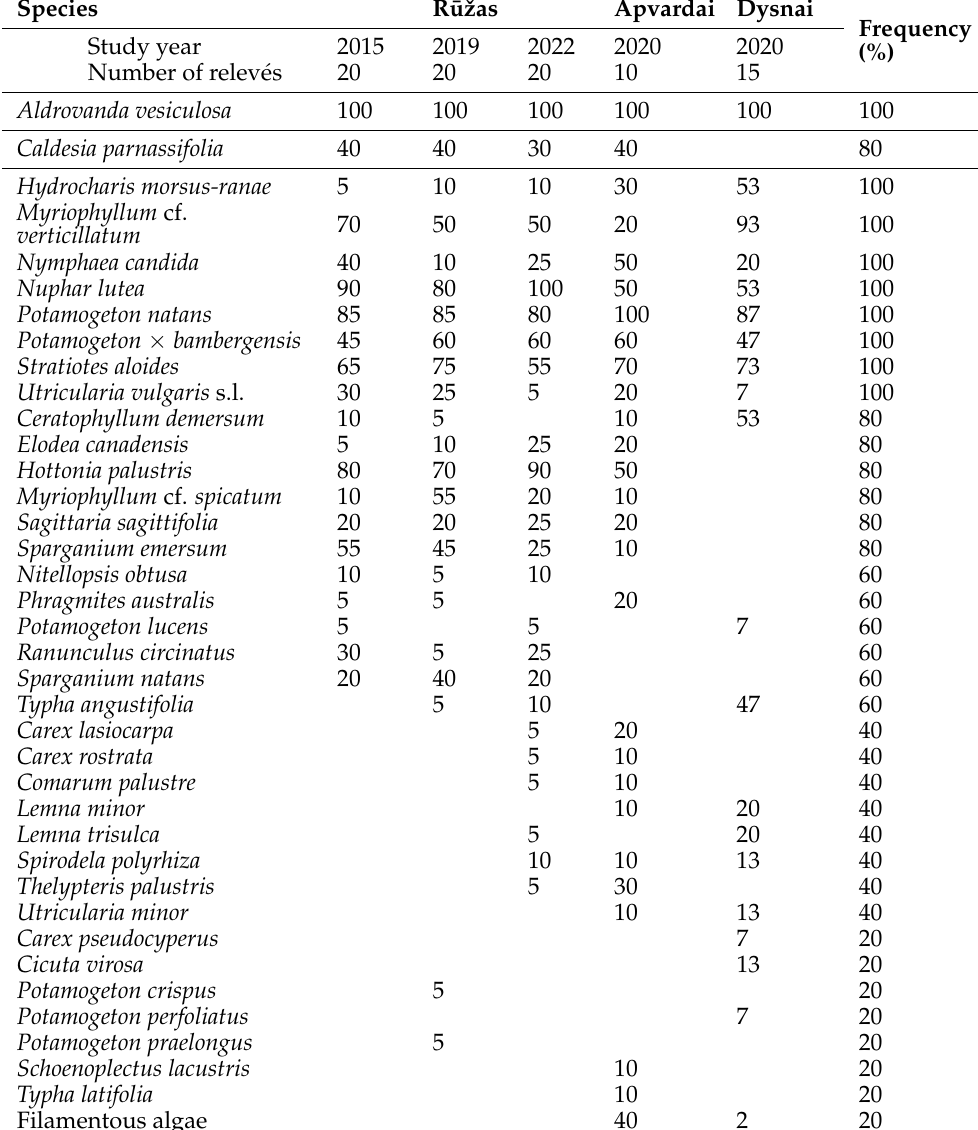
Table A1. Diversity and frequency of species recorded in communities with Aldrovanda vesiculosa and Caldesia parnassifolia in studied lakes and in different years of the